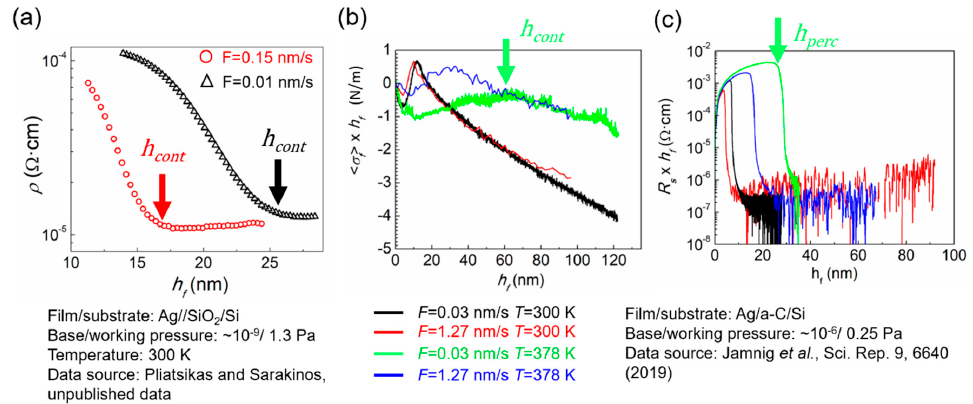
Figure 6. ( a ) ρ vs. h f curves, extracted from in situ spectroscopic ellipsometry, during room-temperature Figure 6. ( a ) 𝜌 vs. ℎ (cid:3033) curves, extracted from in situ spectroscopic ellipsometry, during room- (300 K) magnetron-sputter deposition of Ag films on SiO 2 / Si substrates at two di ff erent deposition rates temperature (300 K) magnetron-sputter deposition of Ag films on SiO 2 /Si substrates at two different F of 0.15 (red circles) and 0.01 nm / s (black triangles). The position of h cont on the curves is indicated by deposition rates 𝐹 of 0.15 (red circles) and 0.01 nm/s (black triangles). The position of ℎ (cid:3030)(cid:3042)(cid:3041)(cid:3047) on the (cid:68) (cid:69) σ × h curves is indicated by solid arrows (unpublished data by Pliatsikas and Sarakinos) ( b ) 〈𝜎 (cid:3033) 〉 × ℎ (cid:3033) vs. solid arrows (unpublished data by Pliatsikas and Sarakinos) ( b ) f f vs. h f curves, extracted from ℎ (cid:3033) curves, extracted from in situ substrate curvature measurements, during deposition of Ag films in situ substrate curvature measurements, during deposition of Ag films on a-C / Si substrates at two on a-C/Si substrates at two values of 𝐹 (0.03 and 1.27 nm/s) and 𝑇 (300 and 378 K). ( c ) 𝑅 (cid:3046) × ℎ (cid:3033) vs. values of F (0.03 and 1.27 nm / s) and T (300 and 378 K). ( c ) R s × h f vs. h f curves, extracted from in situ ℎ (cid:3033) curves, extracted from in situ four-point probe measurements, during deposition of Ag films on four-point probe measurements, during deposition of Ag films on a-C / Si substrates at two values of F a-C/Si substrates at two values of 𝐹 (0.03 and 1.27 nm/s) and 𝑇 (300 and 378 K). The positions of (0.03 and 1.27 nm / s) and T (300 and 378 K). The positions of h cont and h perc on the curves at T = 378 K ℎ (cid:3030)(cid:3042)(cid:3041)(cid:3047) and ℎ (cid:3043)(cid:3032)(cid:3045)(cid:3030) on the curves at 𝑇 = 378 𝐾 and 𝐹 = 0.03 nm/s are indicated by solid arrows. Data and F = 0.03 nm / s are indicated by solid arrows. Data in ( b ) and ( c ) are taken from in ( b ) and ( c ) are taken from [61].